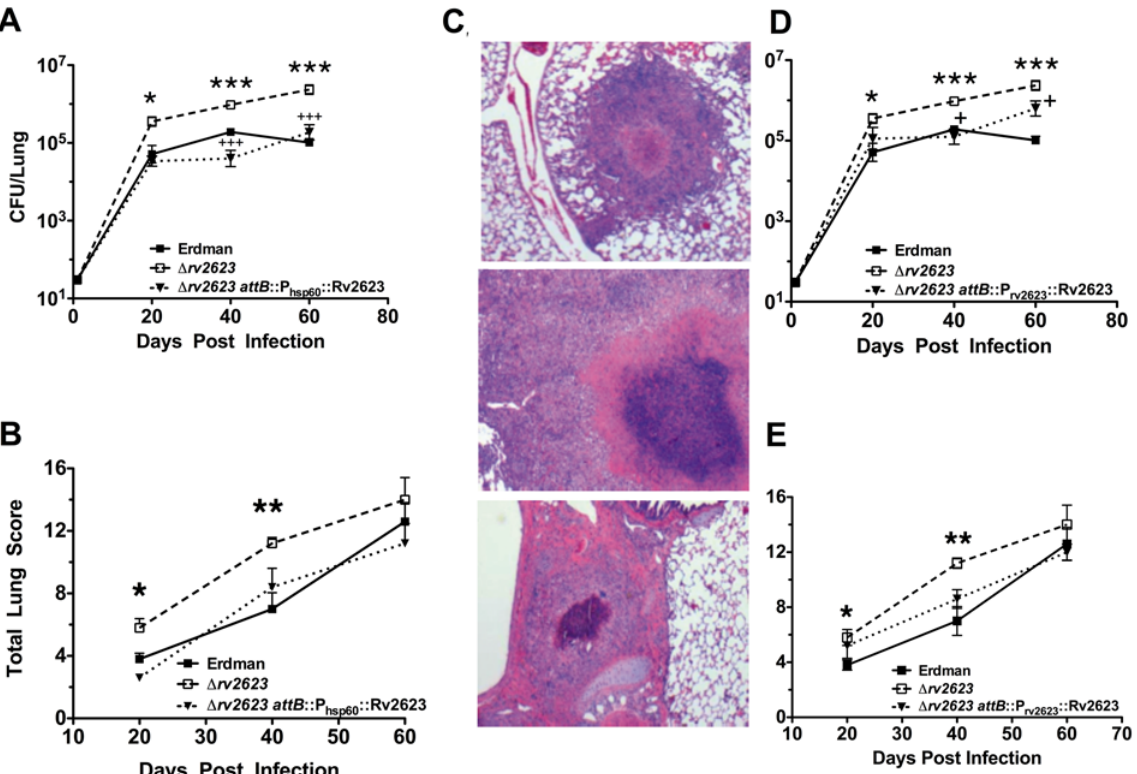
Figure 3. InVivo growth of and pathology caused by D rv2623 in guinea pigs. Outbred Hartley guinea pigs given an aerosol challenge of , 30 CFU were assessed for pulmonic bacterial burden (A,D) and the severity of lung pathology (B,E). Closed box, open box, and triangle represent guinea pigs infected with Erdman, in (A,B,D,E), D rv2623 , in (A,B,D,E), and D rv2623 attB ::P hsp60 Rv2623, in (A,B), or D rv2623 attB ::P rv2623 Rv2623, in (D,E). Comparing the wildtype Erdman and the D rv2623 strains: *p , 0.05; **p , 0.01; ***p , 0.001. Comparing the D rv2623 and the D rv2623 ::complemented strains ( D rv2623 attB ::P hsp60 Rv2623 or D rv2623 attB ::P rv2623 Rv2623): +++ p , 0.001; + p , 0.05. (C) Hematoxylin & Eosin-stained lung sections (40 days post infection) from guinea pigs infected with Erdman (top), D rv2623 (middle), and D rv2623 attB ::P hsp60 Rv2623 (bottom) M. tuberculosis . Error bars represent the standard error of the mean.